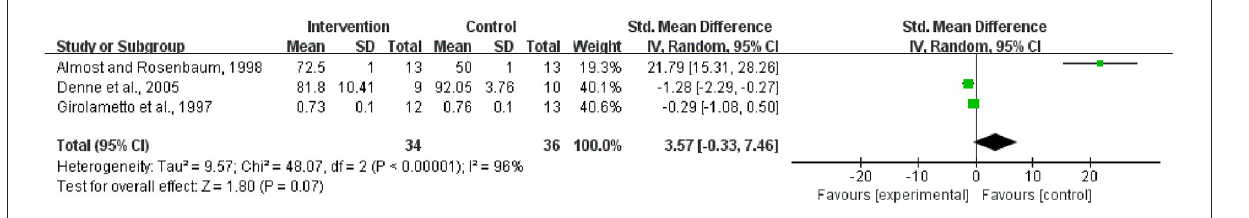
FIGURE2 Meta-analysis outcome of the intervention effect on the proportion of consonants correct in conversation or storytelling. Control, no or delayed treatment.